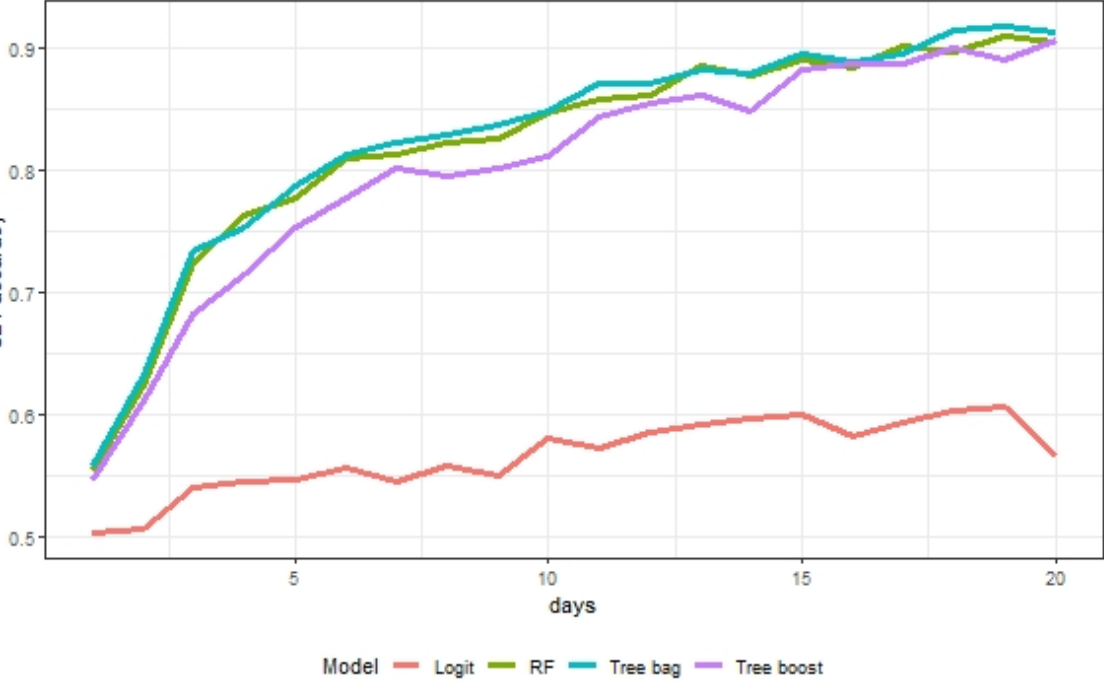
Figure 6. This figure shows the multi-period kappa accuracy for GLD price direction.